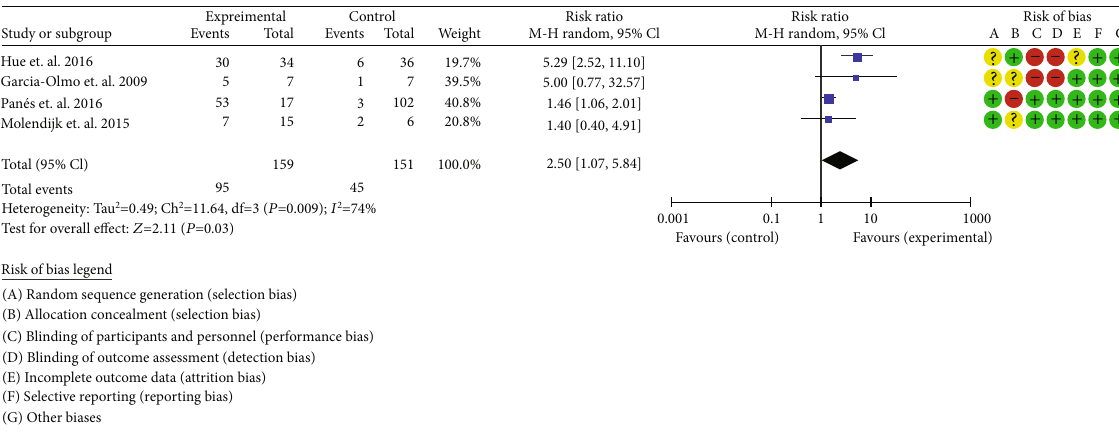
Figure 8: Clinical e ffi cacy (CI: con fi dence interval).